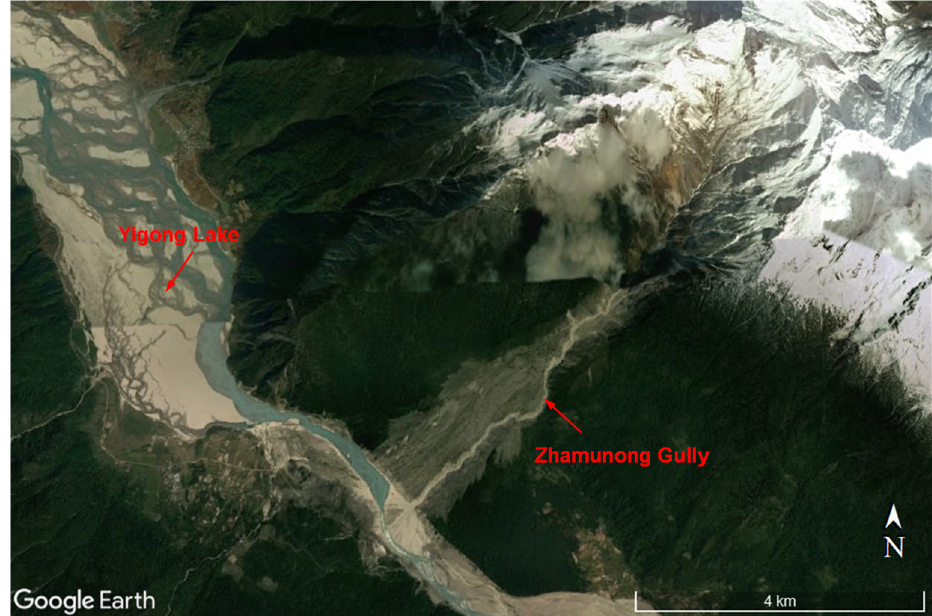
Figure 2. Oblique view of the debris flow gully. Figure 3 is the topographic contour map of the Yigong debris flow. The red dashed